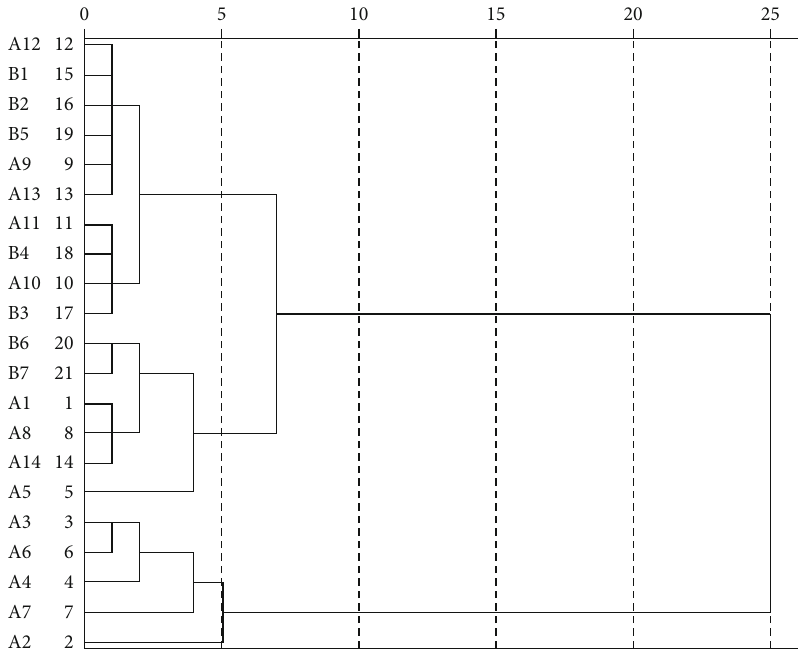
Figure 6: A pedigree of ethanol conversion rate using average linkage (among